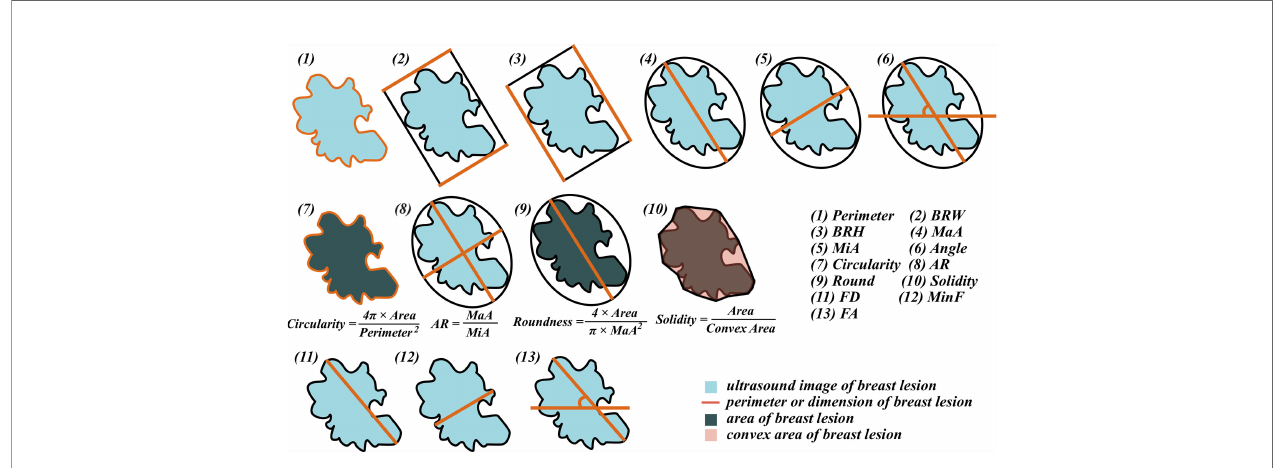
FIGURE 1 | Illustrations of the